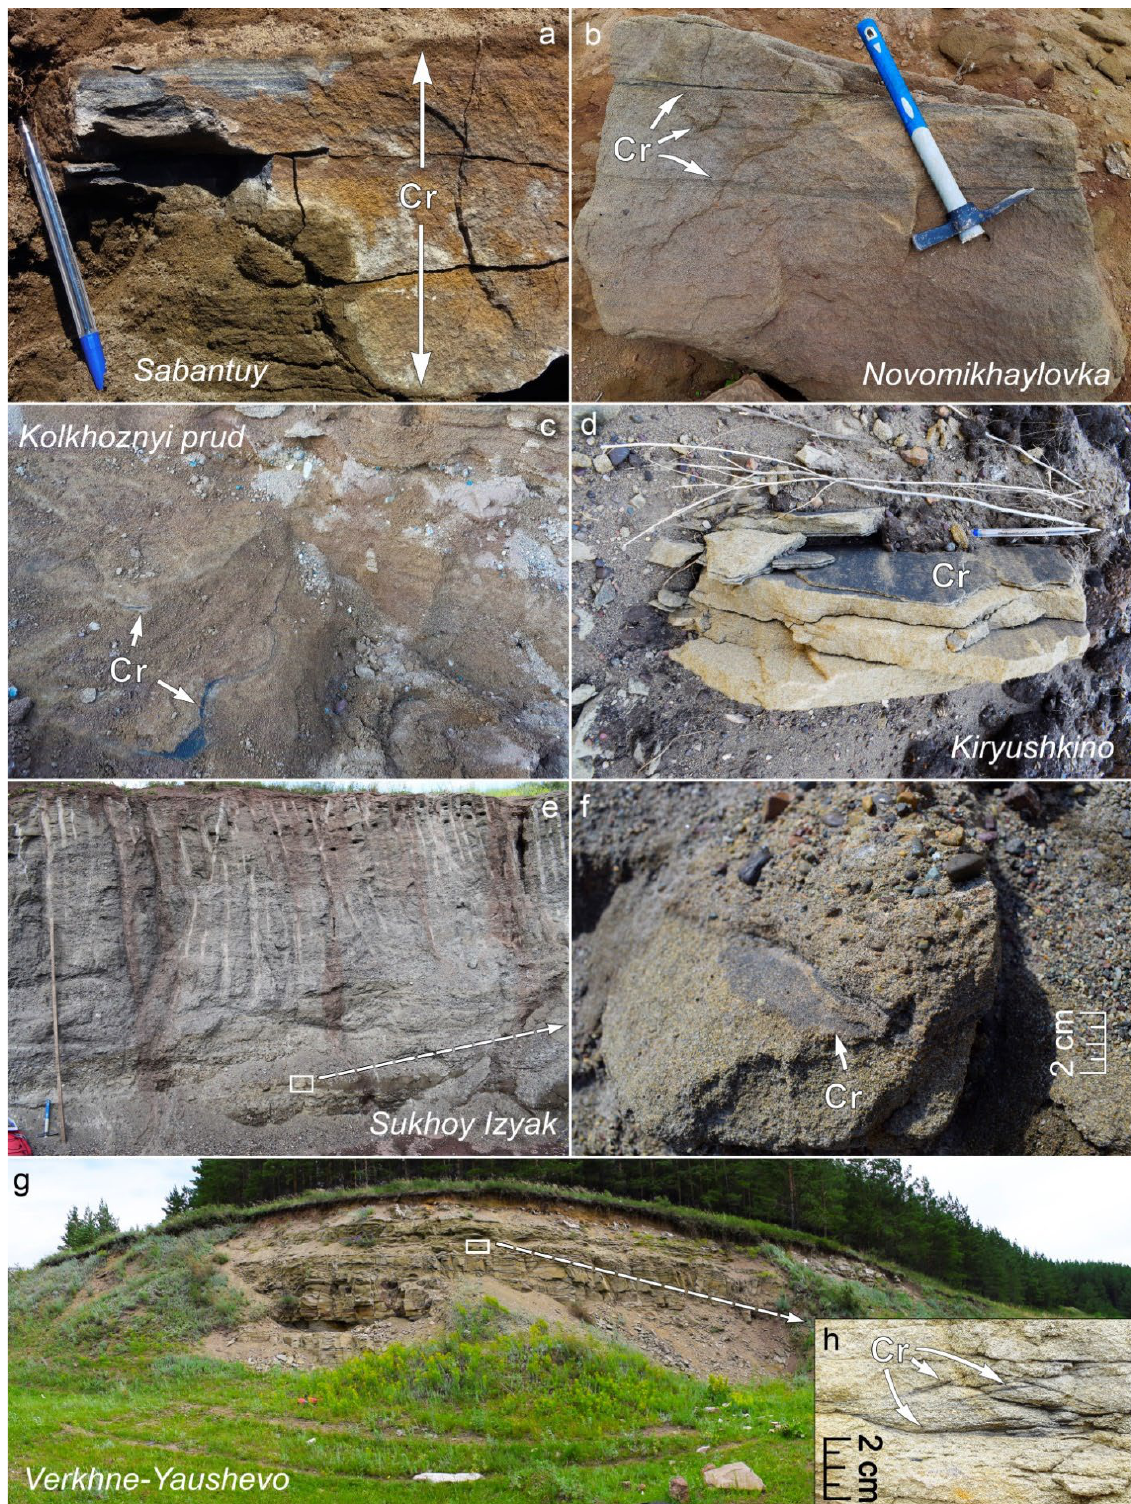
Figure 2. An outcrop of chromite-bearing deposits in the Southern Pre-Urals: ( a )—chromite sandstone in the pit wall, ( b )—sandstone block with chromite-rich layers, ( c )—chromite-rich layers in sandy-gravel quarry wall, ( d )—fragments of chromite sandstones in a quarry, ( e )—gravel quarry wall with a chromite sandstone lens, ( f )—enlarged fragment of image ( e ), ( g )—abandoned quarry wall with chromite sandstones, ( h )—cross-bedding chromite sand layers (enlarged fragment of image ( g )).